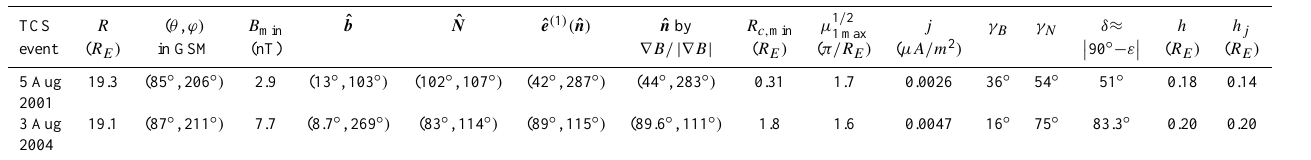
two humps of the current density are in correlated with the